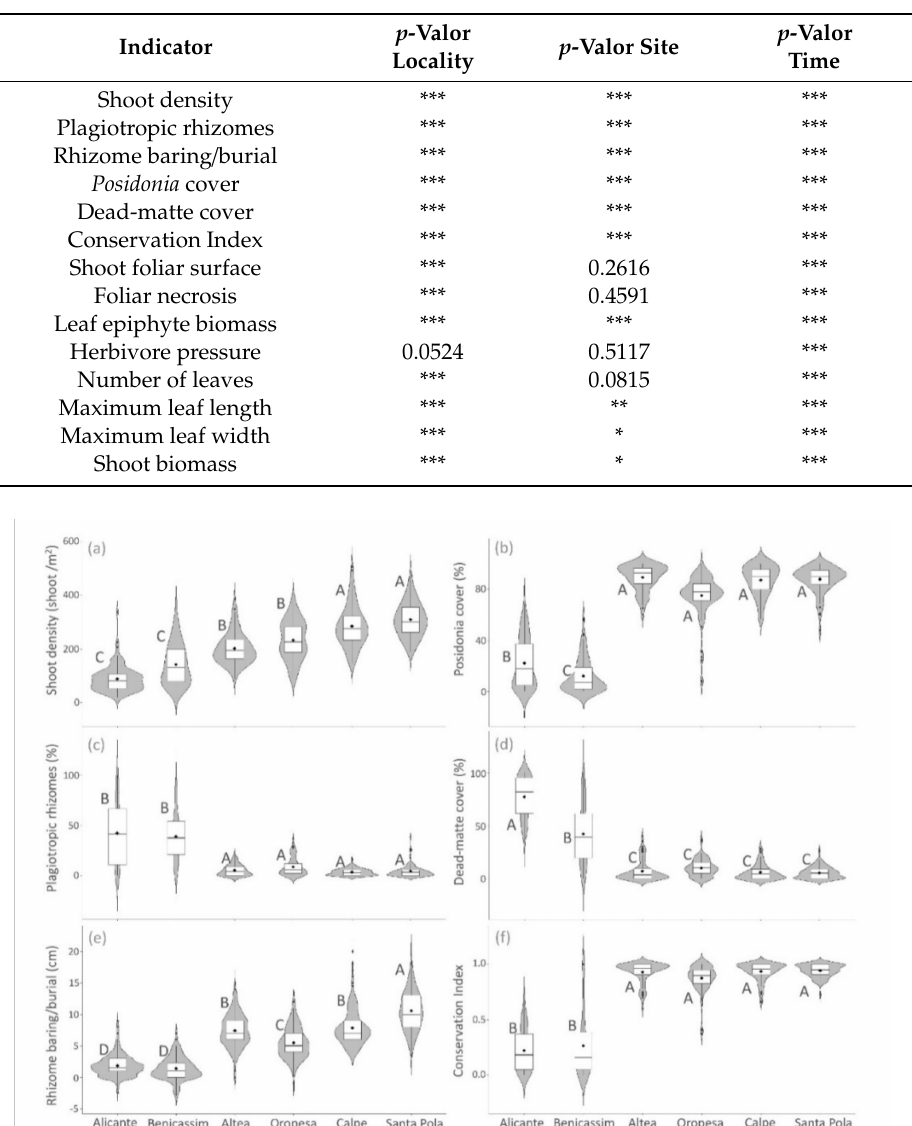
Figure 2. Violin plots for Posidonia meadow structural indicators at each of the six locations, including: ( a ) Shoot density, ( b ) Posidonia cover, ( c ) Plagiotropic rhizomes, ( d ) Dead-matte cover, ( e ) Rhizome baring / burial and ( f ) Conservation Index. Boxplots denote the first and third quartile, the minimum and maximum values are represented as the lower and upper part of the whiskers, the median is symbolized by a black horizontal line, and the mean by a black diamond. Outliers are represented as dot points. Di ff erent capital letters are statistically di ff erent at p <